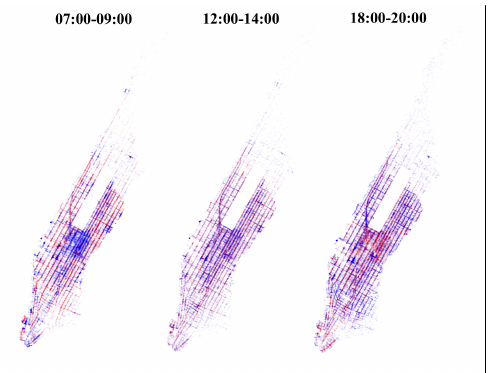
Figure 4. A map of the origin and destination locations of trips in the dataset during three 2-h periods on Wednesday, 20 January 2016. Red dots represent origins; blue dots represent